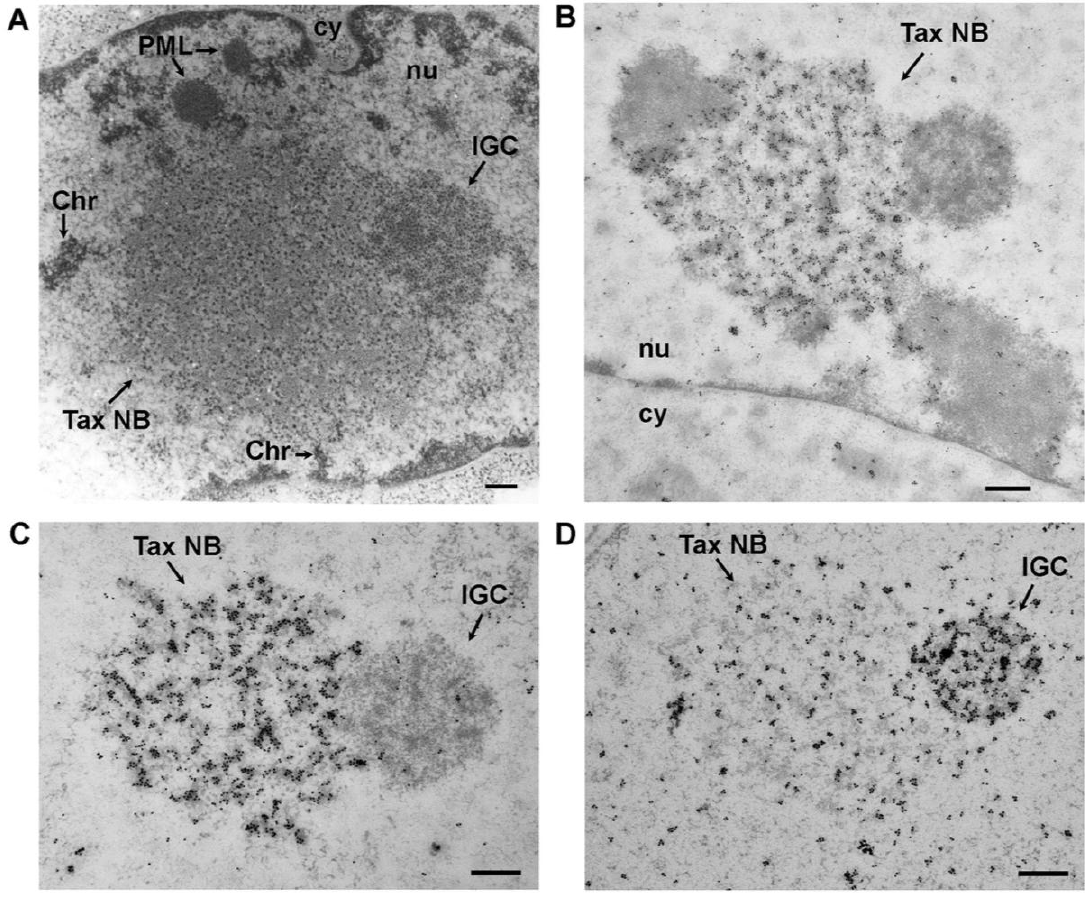
Figure 3. Structure of the Tax nuclear bodies. ( A ) Thin section electron microscopy of Epon embedded Tax expressing BHK21 cells. ( B ) and ( C ) Immunogold labeling with an anti-Tax rabbit polyclonal antibody followed by a secondary antibody conjugated to 15 nm colloidal gold of Lowicryl embedded Tax expressing BHK21 cells. ( D ) Immunogold labeling with an anti-Sm monoclonal antibody and a secondary antibody conjugated to 15 nm colloidal gold. Tax NB, Tax nuclear body; IGC, interchromatin granule cluster; Chr, chromatin; nu, nucleus; cy, cytoplasm. Bar, 0.5